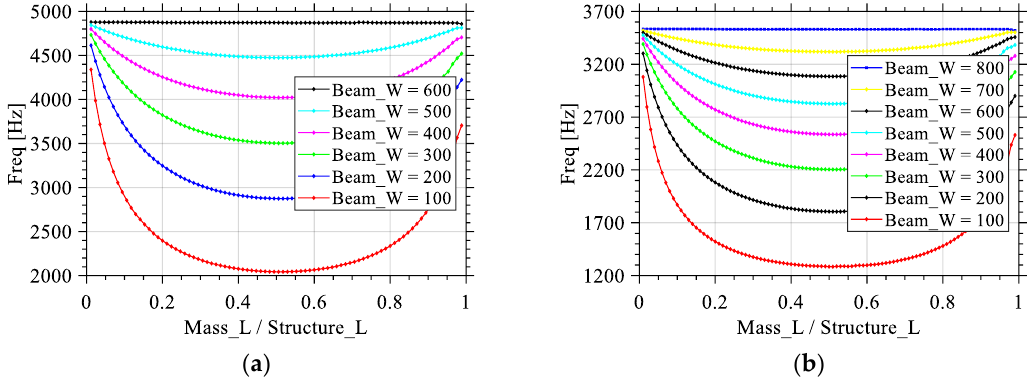
Figure 6. Effects of the variation of ratio of the mass length to the total structure length on the value of the first Eigen frequency for different Beam_W/Mass_W ratios, while conserving a total structure length of ( a ) 1700 µ m and ( b ) 2000 µ m.